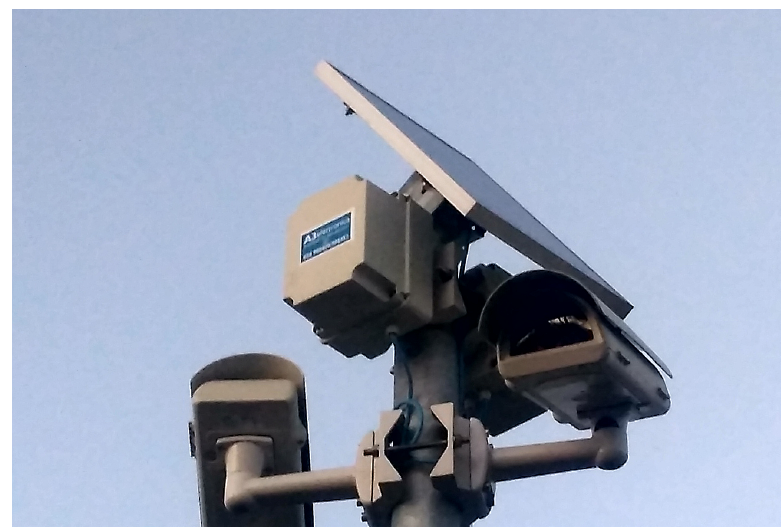
Figure 10. Picture showing the final field test installation.